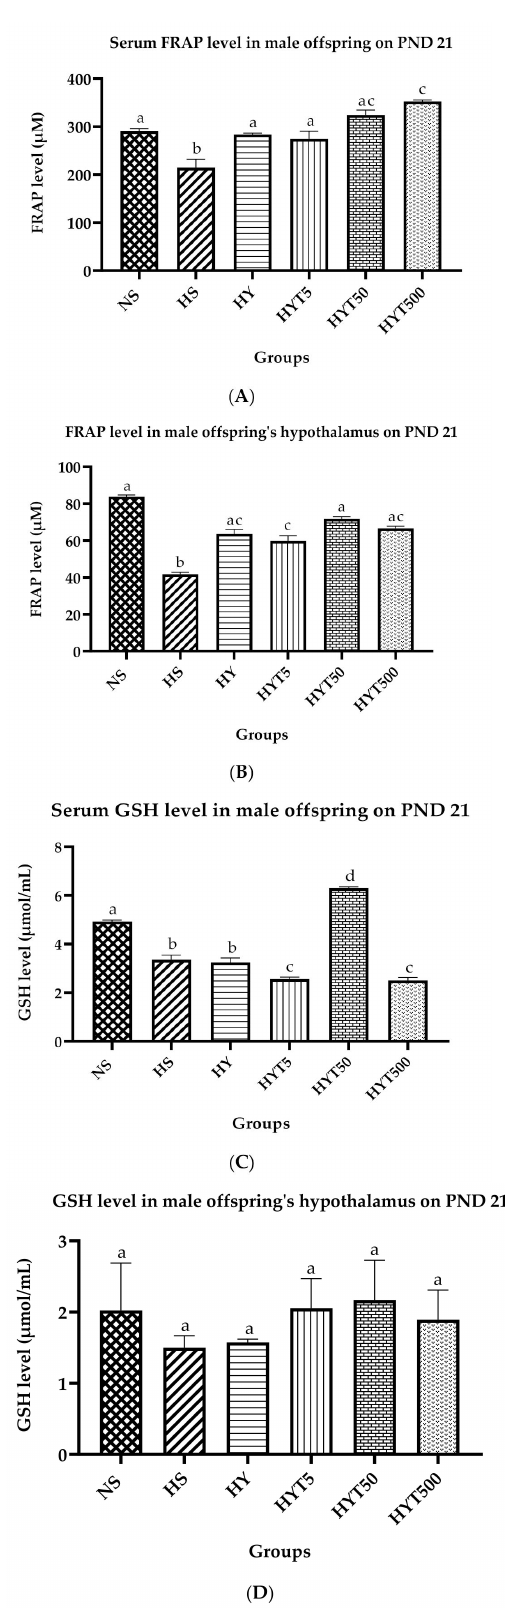
Figure 7. ( A ). The ferric reducing ability of plasma (FRAP) levels in male offspring’s serum on PND 21. ( B ). The ferric reducing ability of plasma (FRAP) levels in male offspring’s hypothalamus on PND 21. ( C ). Serum glutathione (GSH) levels in male offspring on PND 21. ( D ). Glutathione (GSH) levels in male offspring’s hypothalamus on PND 21. Different letters indicates a significant difference at p <